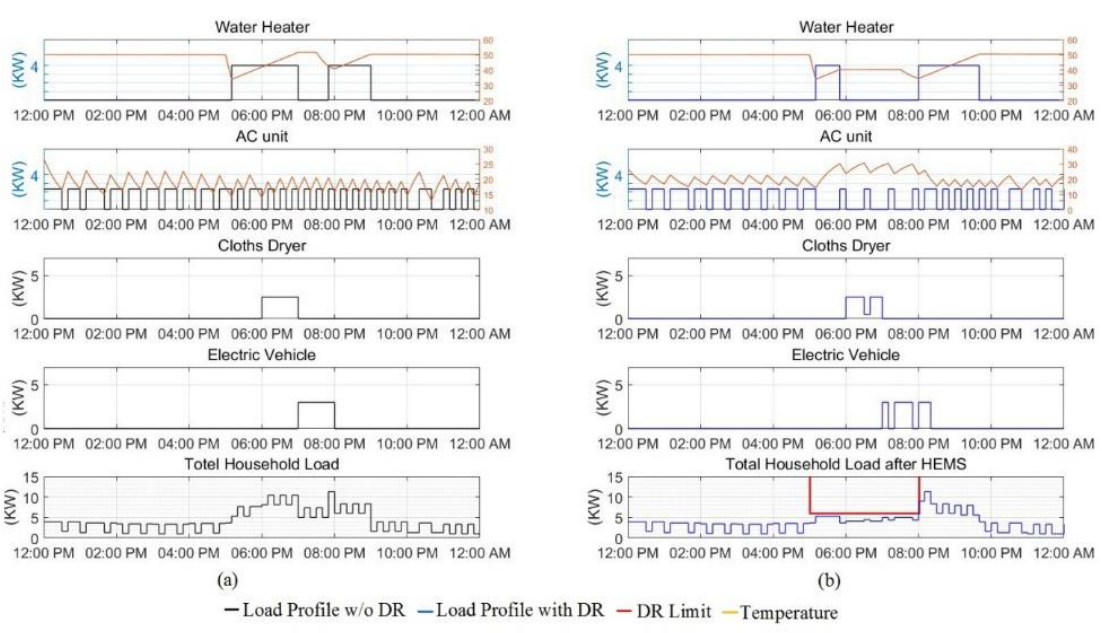
Figure 7. Home load profile for HEMS based on load power control. ( a ) No demand limit; ( b ) 6 KW demand limit.